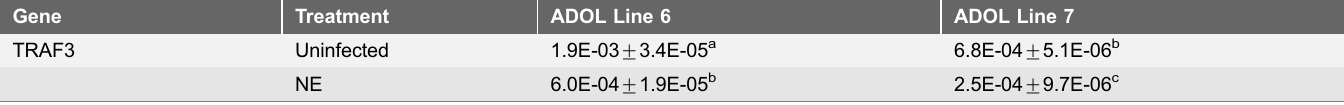
S1 Table. Significant networks from the differentially expressed transcripts ( . 2.0 fold changes, P , 0.05) following NE infection compared with uninfected